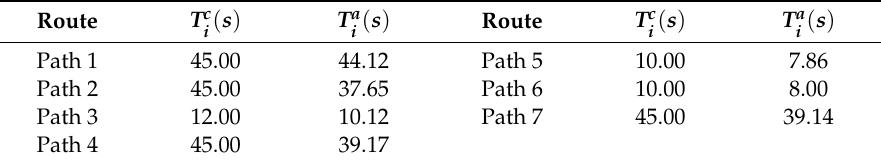
Table 8. Coverage periods and actual coverage time for each